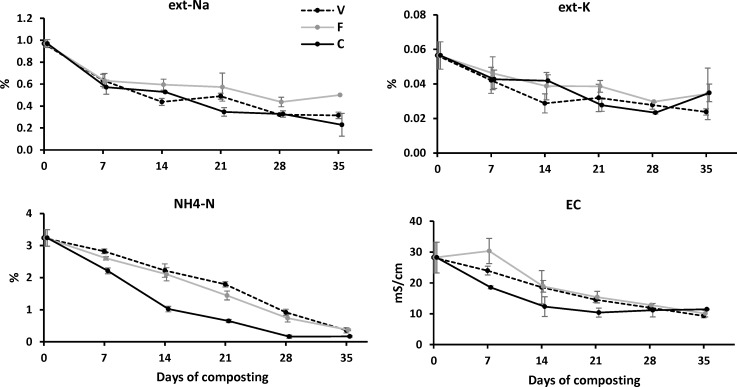
Extractable-Na, extractable-K, NH4-N and electrical conductivity variation of V, F and C composts.